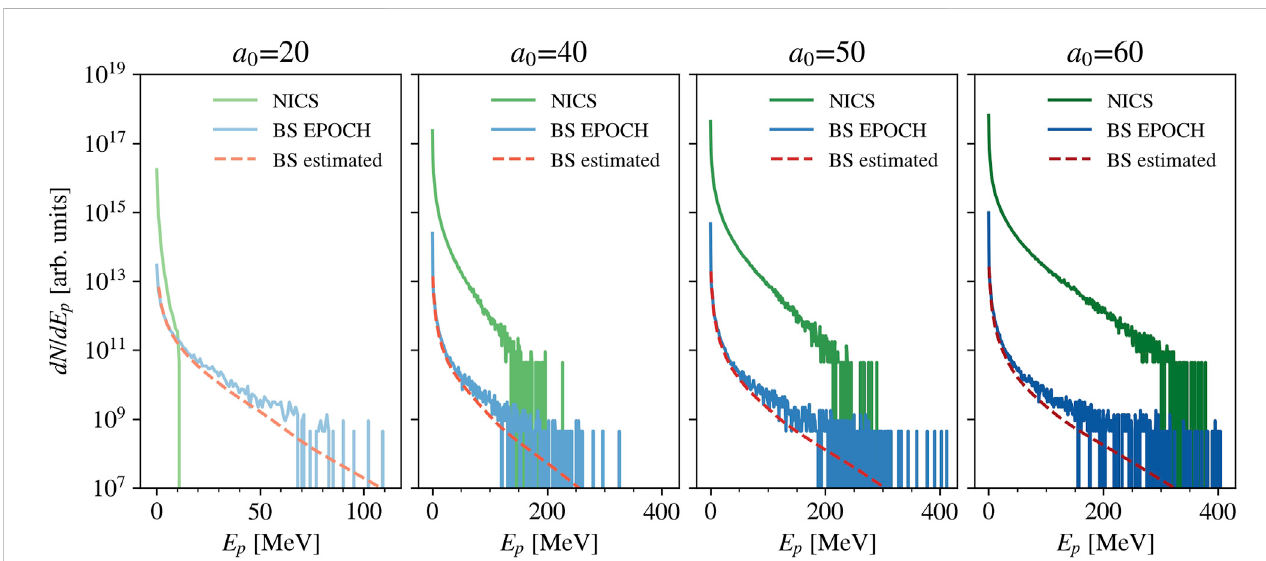
FIGURE 5 Spectra of emitted photons in the case of foam thickness 25 µm and foam density 1 n c varying the parameter a 0 (20 – 40 – 50 – 60). The reported spectra refertoNICSemission fromSmilei simulations (solidlinesingreen),bremsstrahlung(BS)emission simulatedwiththePIC codeEPOCH(solidlinesinblue)and estimated analytically (dashed lines in